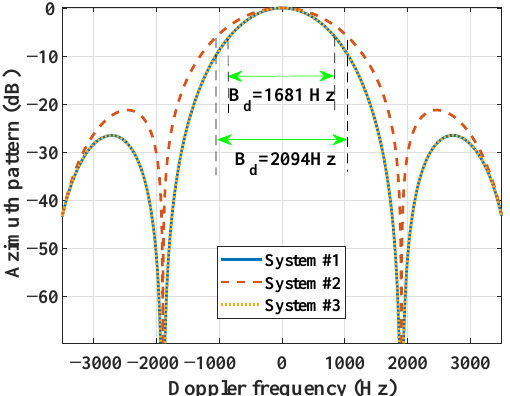
Figure 5. Configuration of systems #1, #2 and #3. Systems #1 and #2 have the same length of Rx antenna, while systems #2 and #3 have the same number of channels.